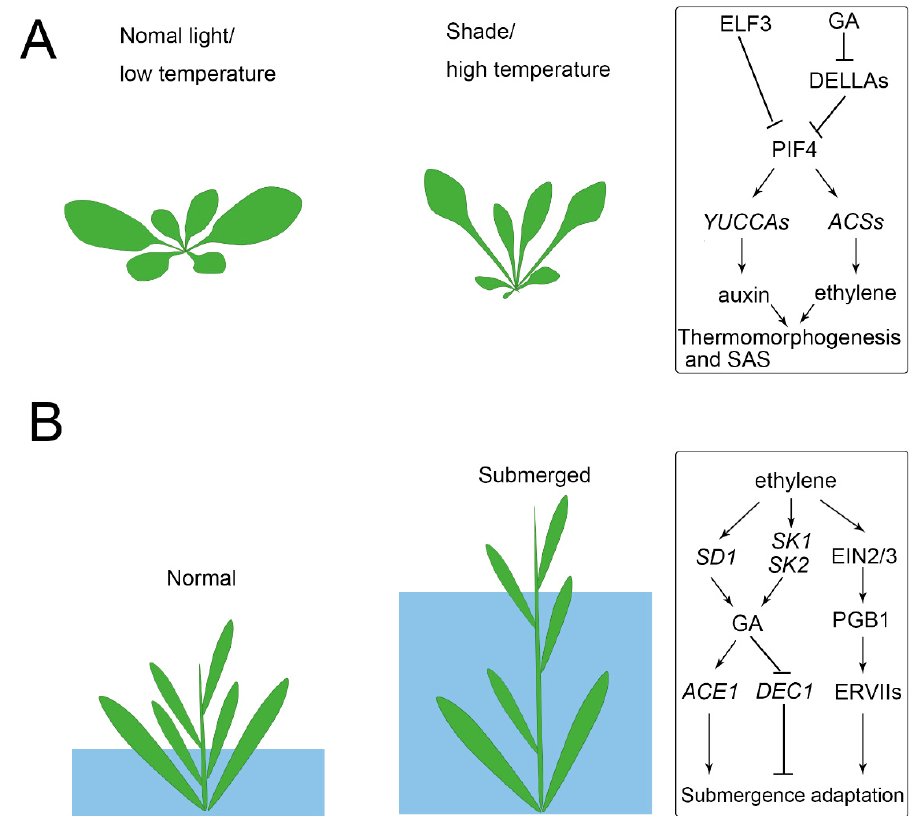
Figure 2. Example of plant developmental responses to environmental changes. ( A ) Both shaded light and an increase in temperature induce the elongation of the petiole, a reduction of leaf area, and an upward movement of the leaves. ELF3 directly represses PIF4, and this repression was released in shade/high temperature conditions. PIF4 activates auxin synthesis by upregulating YUCCAs and activating ethylene synthesis by upregulating ACSs for thermomorphogenesis and shade avoidance syndrome (SAS). Shade/high temperature also induces high levels of gibberellic acid (GA) and the degradation of DELLAs, which therefore release PIF4 for binding to target promoters. ( B ) Deepwater rice activates stem elongation growth depending on the water level. Submerged conditions accumulate high ethylene and activate SD1 for GA synthesis. GA promotes stem elongation through the activation of ACE1 and repression of DEC1 . Ethylene also induced EIN2/EIN3 signaling and thus enhanced PGB1 to improve ERFVII stability for flooding